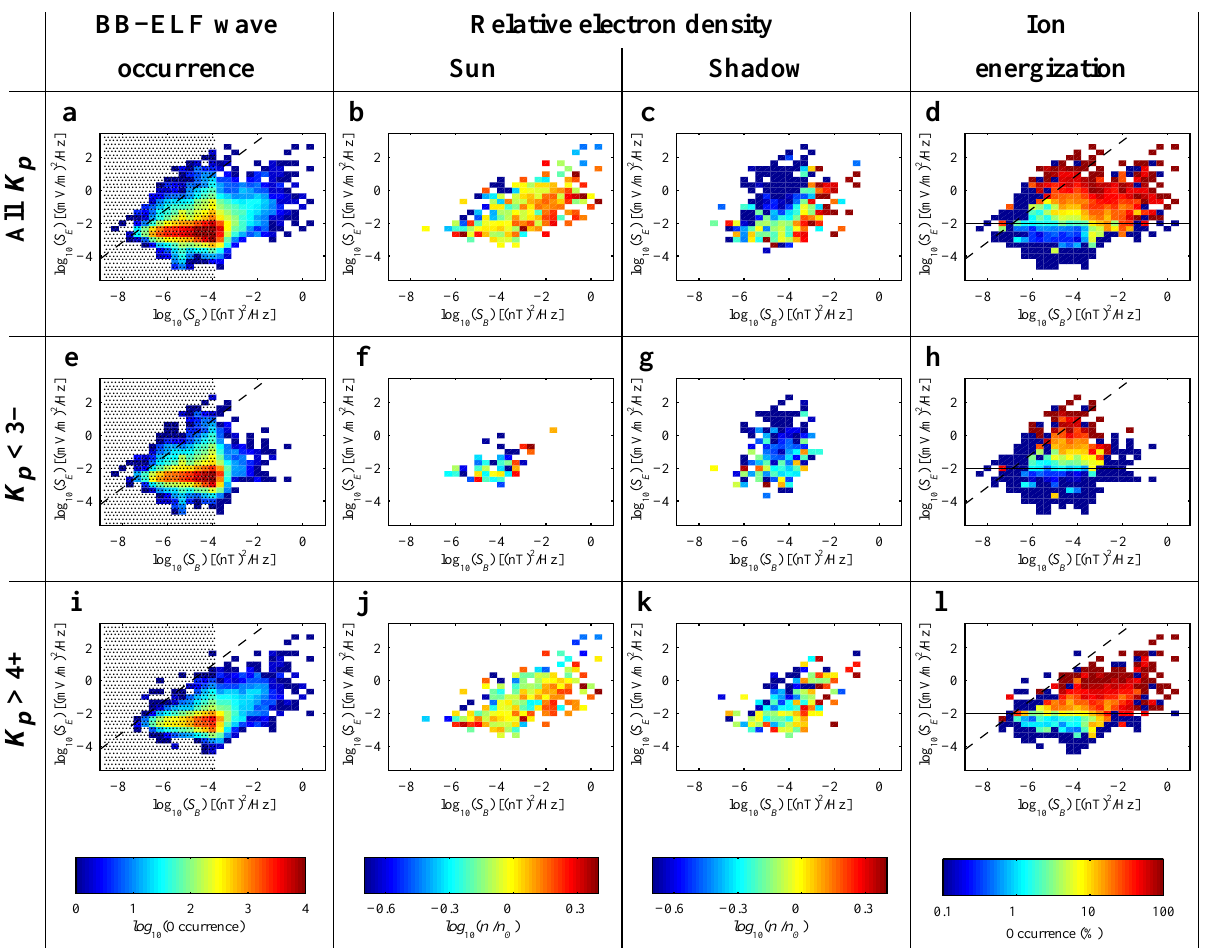
Fig. 5. The left column shows the number of measurements of BB-ELF waves versus different electric and magnetic field spectral densities ( S E and S B ) at the oxygen gyrofrequency at the Freja altitudes. The next two columns show the relative electron densities observed during ion energization events in the presence of these BB-ELF waves above a sunlit and a dark ionosphere, respectively. The probability of detecting the energized ions in the presence of the waves is shown in the last column. The top row corresponds to all K p indices, middle row to K p < 3 − , and last row to K p > 4 + . The solid lines at S E = 10 − 2 (mV) 2 /Hz in ( d ), ( h ), and ( l ) indicate the threshold used in this paper for the waves being important for the ion heating. The dashed lines in the leftmost and the rightmost columns show the location of the speed of light, S E /S B = c 2 , and the shadings in ( a ), ( e ), and ( i ) indicate the regions where some of the S B data are contaminated with an artificial signal — see the text for